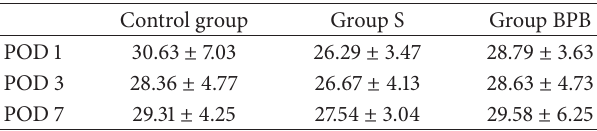
Table 1: Primers of proinflammatory cytokines. Gene